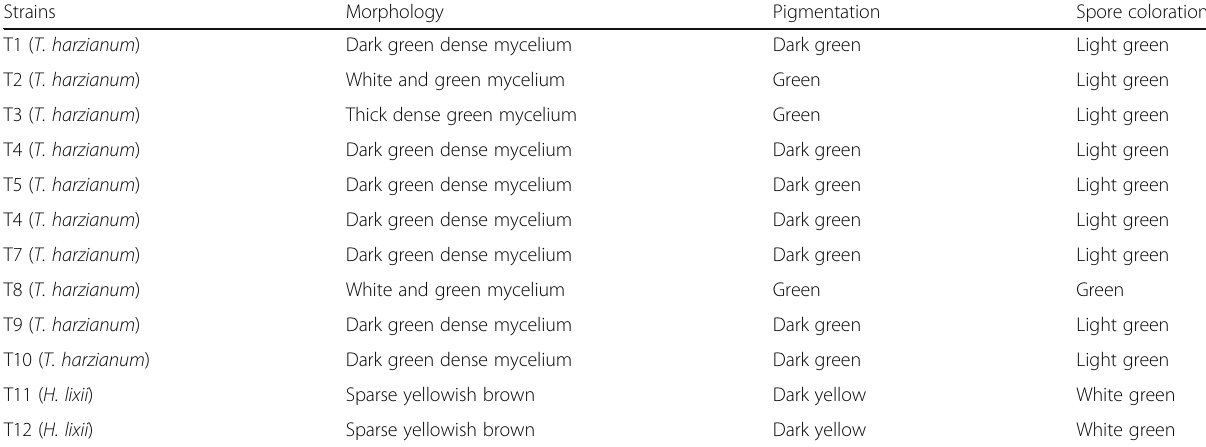
Table 1 Colony morphology, pigmentation, and sporulation of Trichoderma isolates Strains Morphology